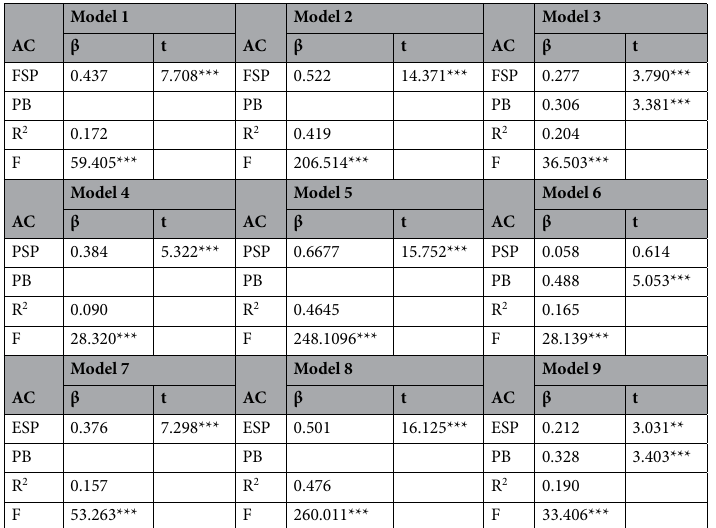
Table 5. Mediation model testing of perceived benefits (N = 288). In Model 1, food-safety pressure predicts acceptance. In Model 2, food-safety pressure predicts perceived benefits. In Model 3, food-safety pressure and perceived benefits predict acceptance. In Model 4, production-safety pressure predicts acceptance. In Model 5, production-safety pressure predicts perceived benefits. In Model 6, production-safety pressure